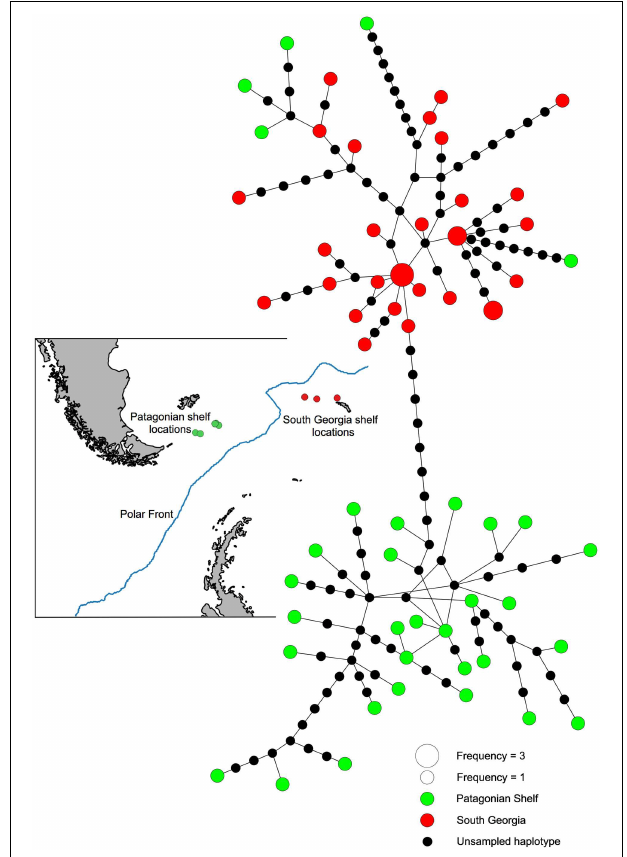
FIGURE 5 | Statistical Parsimony network indicating sampling locations and genetic relationships among Patagonian (green) and South Georgian (red) Ophiura lymani haplotypes.